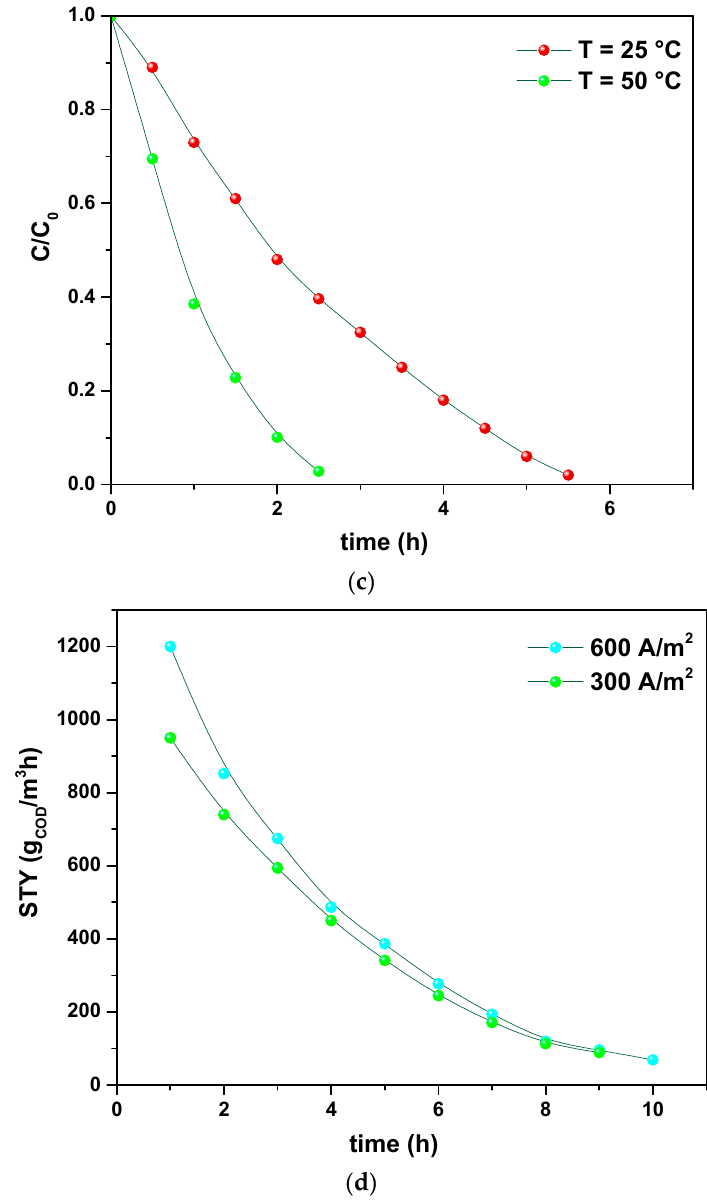
Figure 9. Concentrations expressed as C/C 0 of tannic acid, organic intermediates, and COD during the simpler model tannery wastewater oxidation using PVDF HFP_RuO 2 60: pH = 6.5, applied current density of 600 A/m 2 , T = 20 °C ( a ). Effect of pH on COD evolution during the electrolysis of the simpler model tannery wastewater: T = 20 °C, applied current density of 400 A/m 2 ( b ). Influence of temperature during the electrolysis of the simpler model tannery wastewater: pH = 7.5, applied current density of 450 A/m 2 ( c ). Evolution of STY during the simpler model tannery wastewater oxidation at different applied current densities: T = 20 °C, pH = 6.5 ( d ).